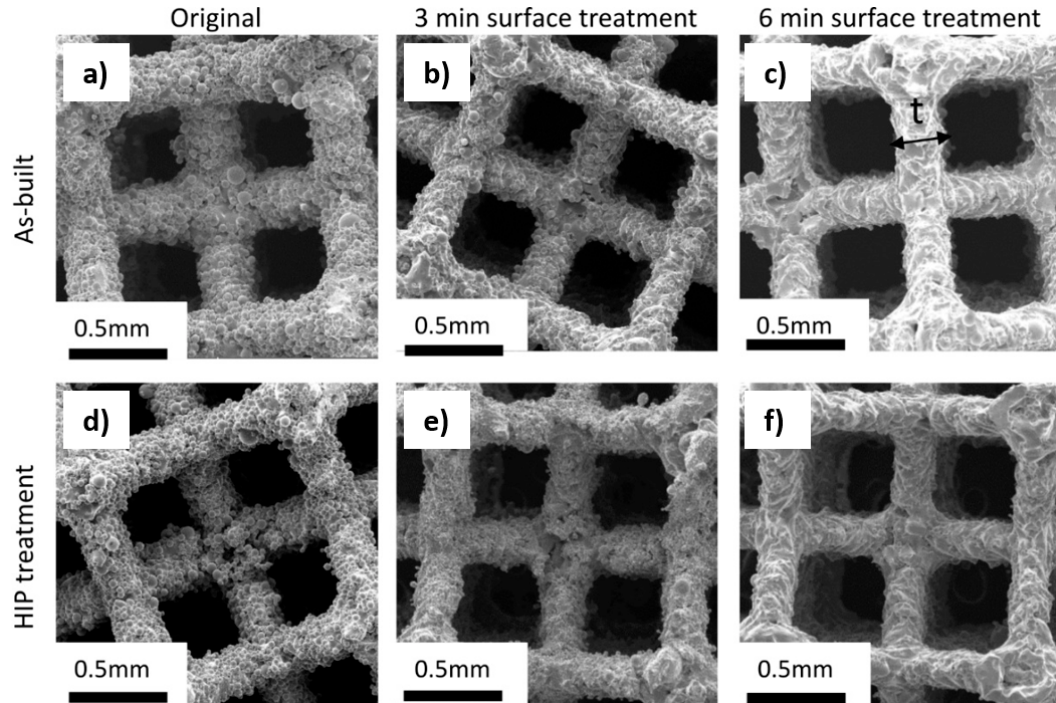
Figure 4. Secondary electron micrographs of the representative specimens selected from each tested batch. Comparison of the postprocessing effect on a specimen surface (batch/strut thickness in ( × 0.001) mm): ( a ) as-built specimen with original surface (B/322 ± 21); ( b ) as-built specimen after 3 min etching (B3/277 ± 21); ( c ) as-built specimen after 6 min etching (B6/243 ± 21); ( d ) HIP-ed specimen with original surface (H/310 ± 23); ( e ) HIP-ed specimen after 3 min etching (H3/287 ± 21); ( f ) HIP-ed specimen after 6 min etching (H6/234 ± 18) [37].